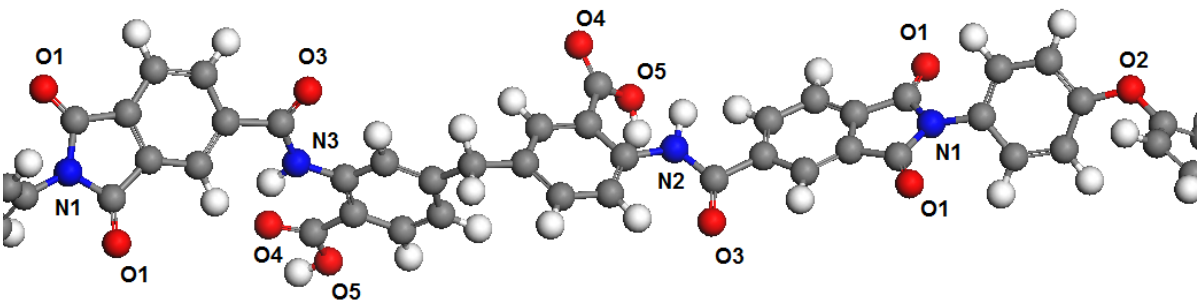
Figure 2. Fragment of the PI-PAA polymer chain with marked atoms according to Table 2.